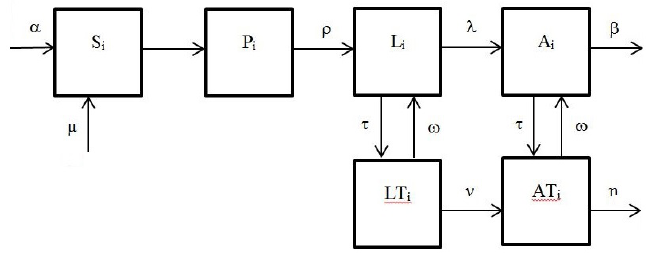
Figure 1. The San Francisco City Clinic Cohort (SFCCC) model with testing and